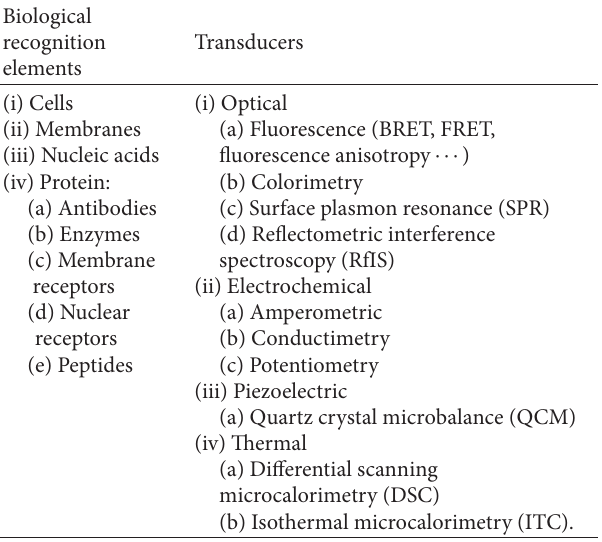
Table 2: Biological recognition elements and transducers usually used in the development of